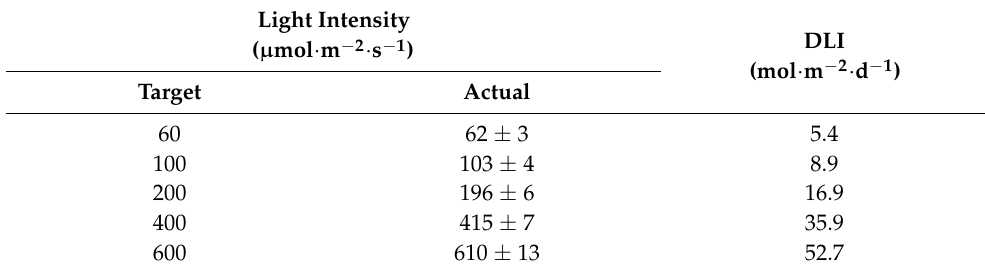
Table 1. Target and actual light intensity ( ± SD ) and daily light integral (DLI) ( ± SD ) during the seedling growth stage (14 d) of lettuce ‘Rex’ ( Lactuca sativa L.) over three replications in